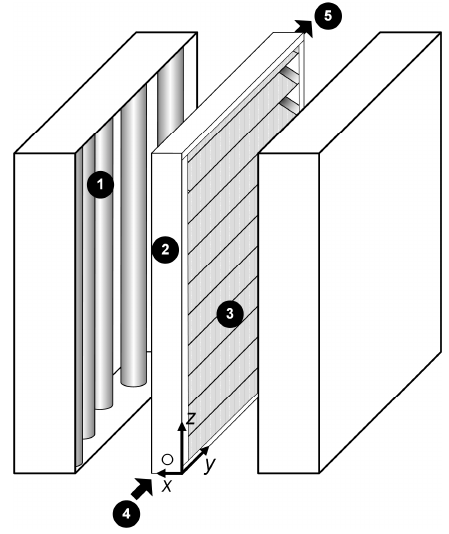
Figure 4. Corrugated wall reactor: (1) UV lamps; (2) acrylic frame; (3) stainless steel corrugated plate coated with TiO 2 ; (4) reactor inlet; and (5) reactor outlet. Adapted with permission from Passalía, C.;